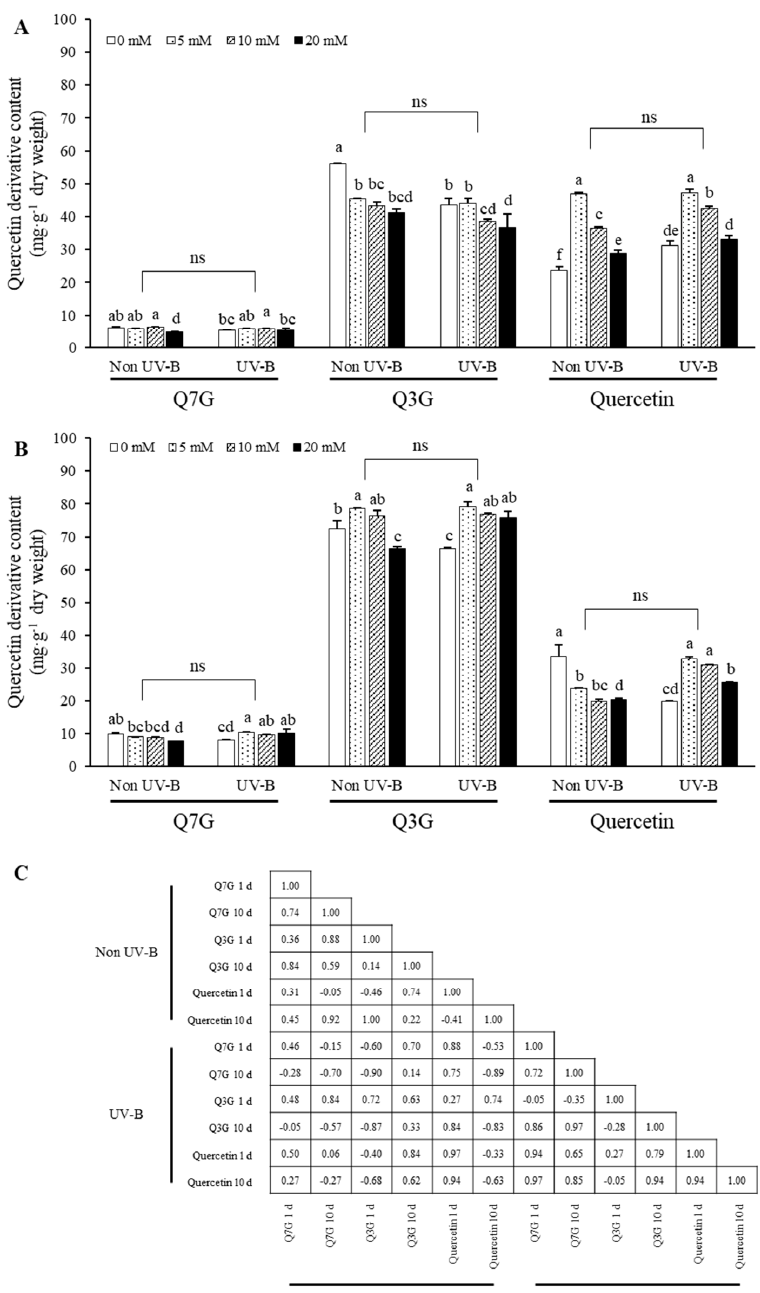
Figure 4. Quercetin derivatives content in marigold petals treated with different MeJA concentrations with/without UV-B (1 W ∙ m − 2 ∙ s − 1 ) for 1 h/day × 1 day (short period treatment) ( A ) and 1 h/day × 10 days (long period treatment) ( B ). Correlation of individual flavonoids by treatment ( C ). Different letters within each group (Q7G, Q3G, and Quercetin) in ( A , B ) indicate significant differences by Tukey’s studentized test at p < 0.05. Significant difference between non-MeJA and MeJA in each group was performed by Student’s t -test. Correlation was performed with Pearson correlation coefficient test. Q7G, Quercetin-7- O -glucoside; Q3G, Quercetin-3- O -glucoside. Content of Q7G is expressed mg Q3G equivalents · g − 1 dry weight. All data is expressed mean ± standard deviation of three